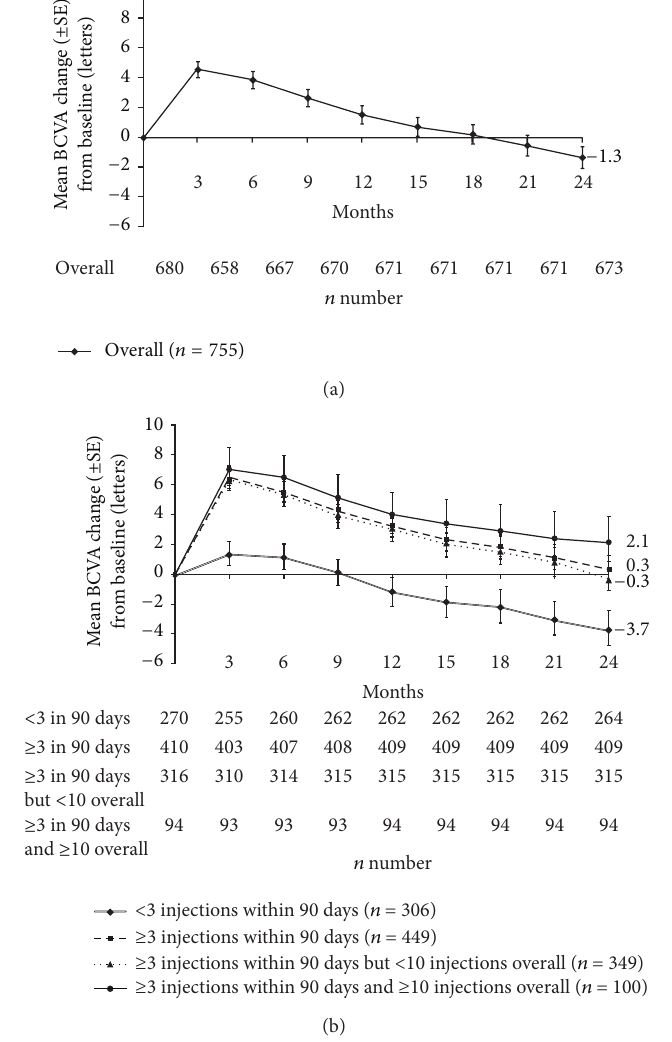
Figure 2: (a) Overall mean change in BCVA over time in the first-treated eye and (b) mean change in BCVA overtime based on the number of injections in the first-treated eye (safety set, LOCF). Safety set was defined as all those patients who were treated with at least one dose of ranibizumab and who had at least one safety assessment after study entry and no protocol deviations that warranted exclusion. Baseline VA results were recorded for 680 patients. Month 24 results were evaluated for 673 patients using the LOCF approach. BCVA: best-corrected visual acuity; LOCF: last observation carried